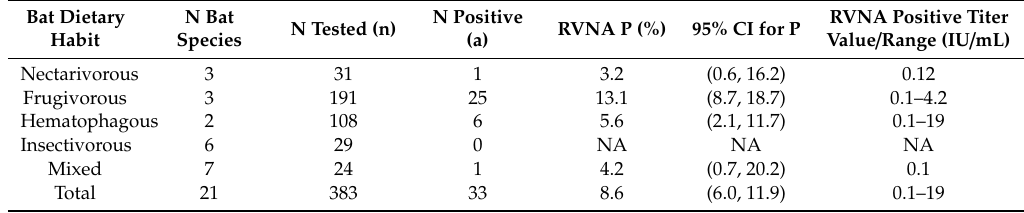
Table 2. RVNA prevalence and titer values for di ff erent bat dietary